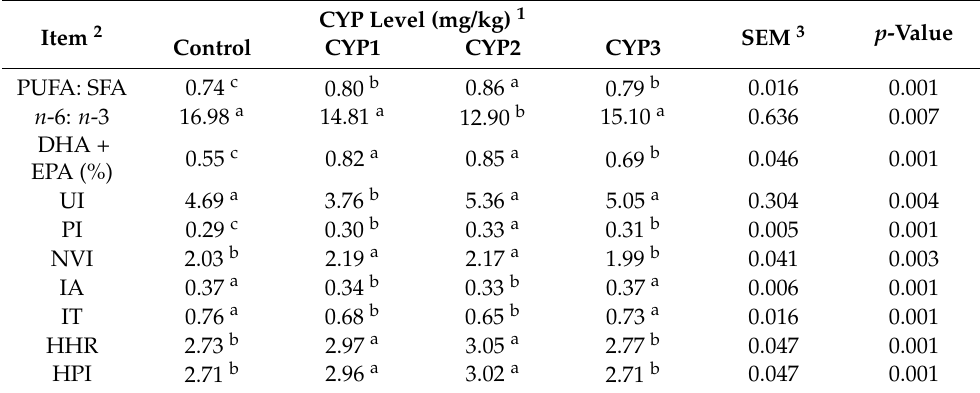
Table 7. Effects of CYP on fatty acid nutrition index in thigh muscle of broilers. Item